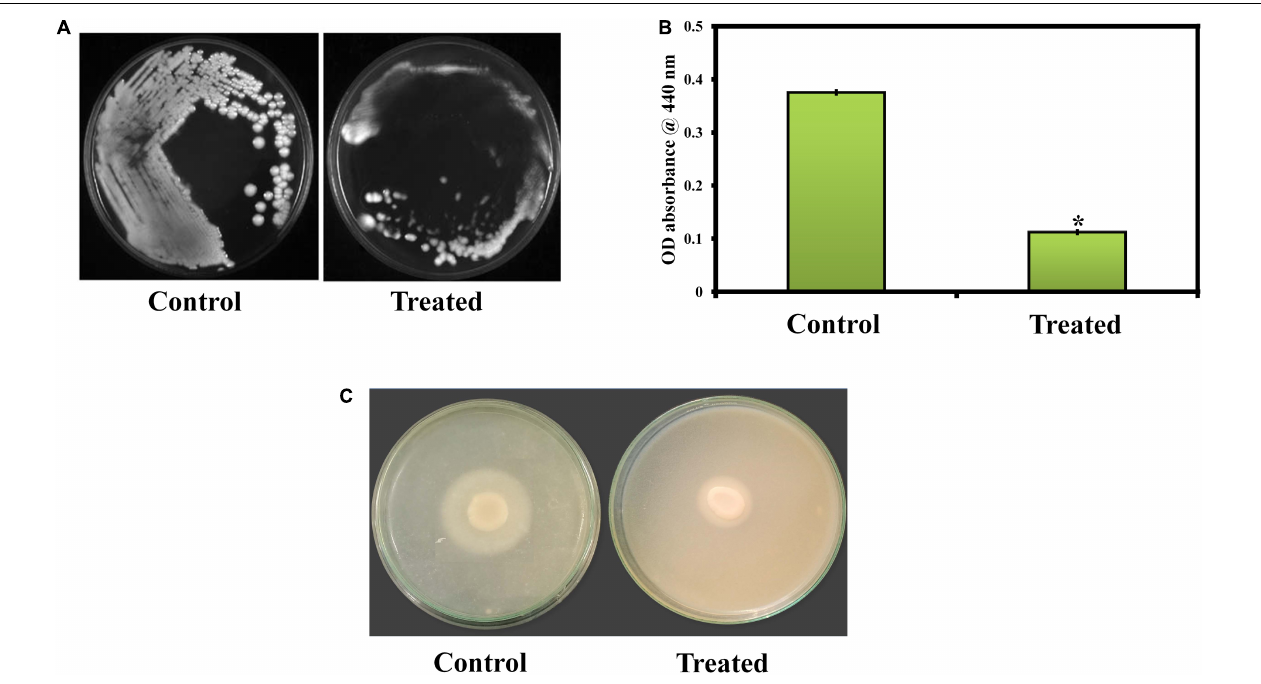
FIGURE 5 | (A) Activity of morin against C. albicans in an agar invasion assay. (B) Effect of morin on C. albicans protease production at the increasing concentration (37.5, 75, and 150 µ g/ml). Data are presented as means ± SD. *Indicates the statistical significance ( p < 0.05). (C) Effect of morin (at MBIC) on C. albicans phospholipase